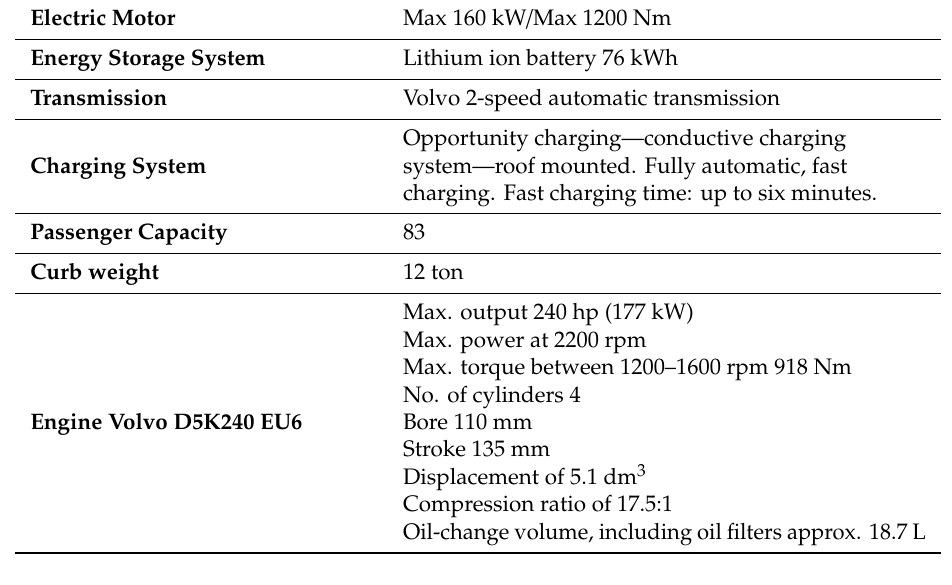
Table 6. Technical specifications of plug-in 7900 Electric Hybrid bus from Volvo (PHEV).